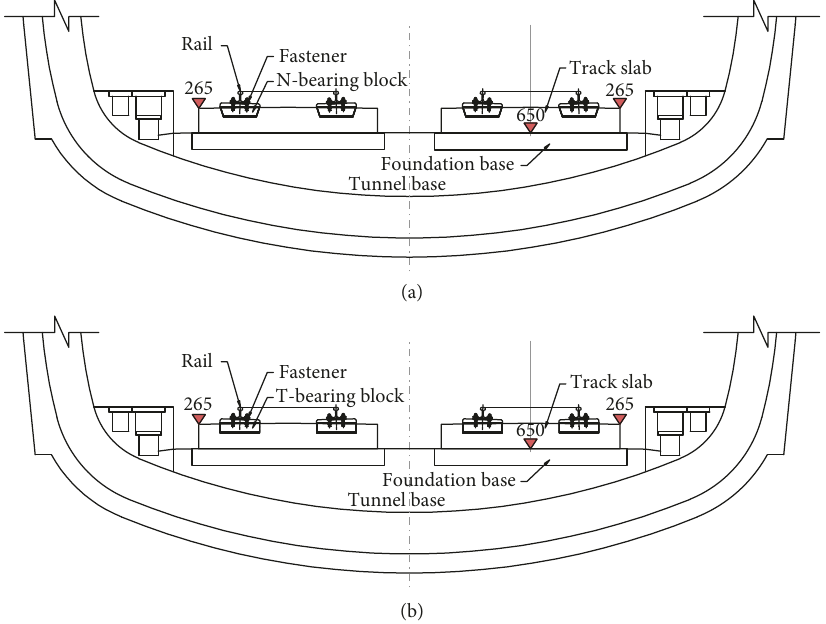
Figure 2: Cross section of LVTs in tunnel (unit: mm). (a) N-LVT cross section in tunnel. (b) T-LVT cross section in